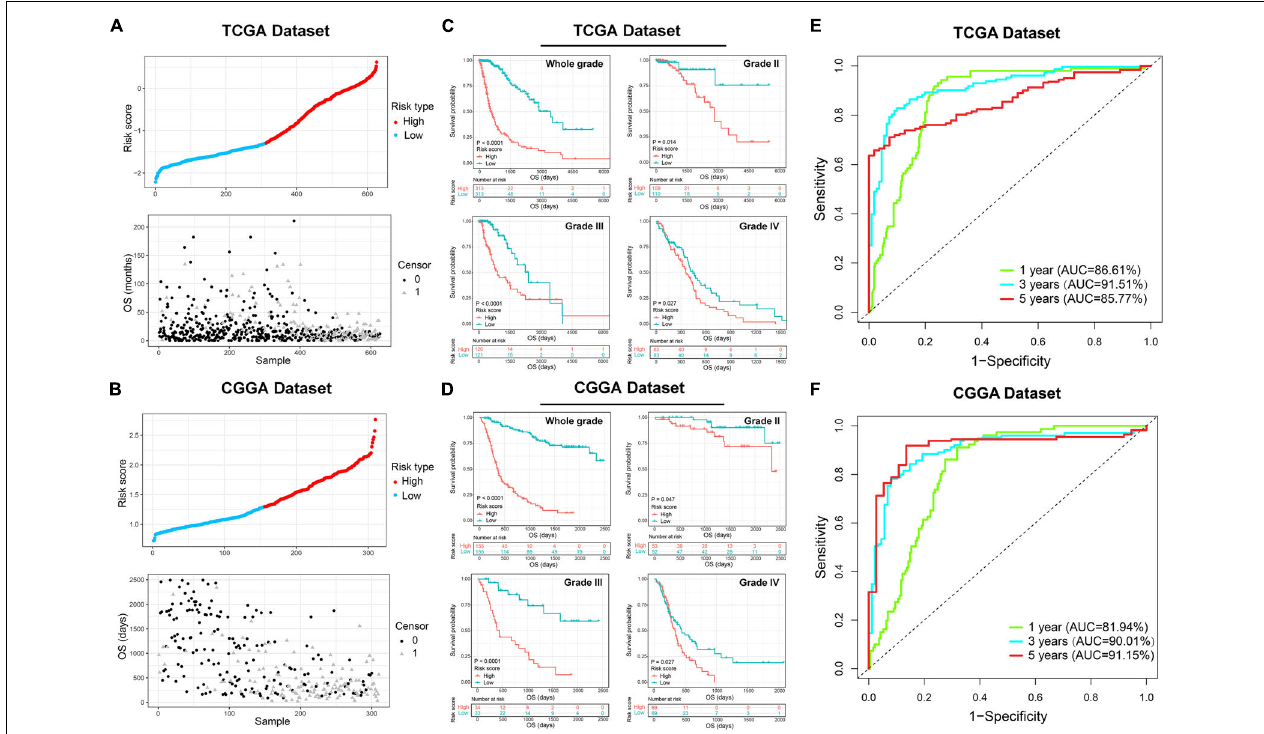
FIGURE 4 | The prognostic value of the ER stress-related signature in TCGA and CGGA datasets. (A,B) The distribution of the risk score and survival overview of patients with gliomas. (C,D) K-M survival analyses of the risk signature in glioma patients stratified by WHO grade. (E,F) The time ROC curve analyses were performed to predict 1 − , 3 − , and 5-year OS according to risk score.